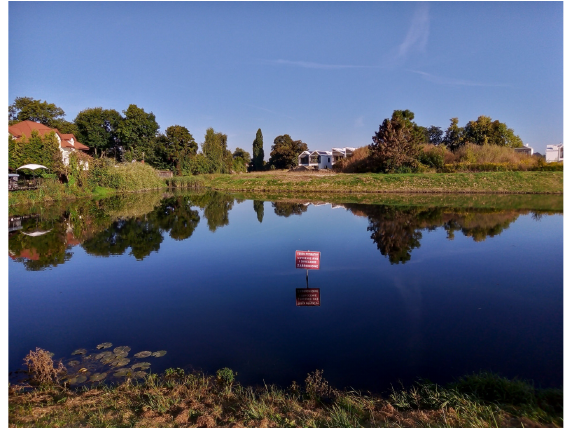
Figure A8. W ą sal Pond reservoir at Katarynki Street (source: own).